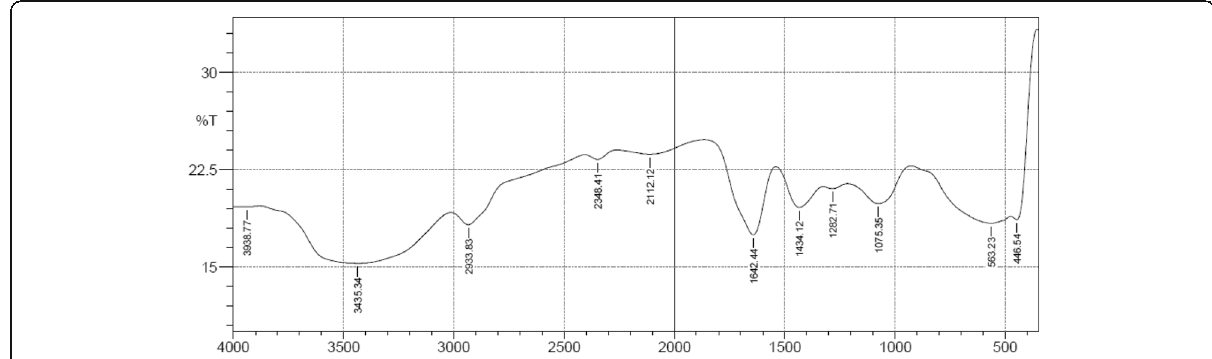
Fig. 2 FTIR spectra for ethanol extract of F.